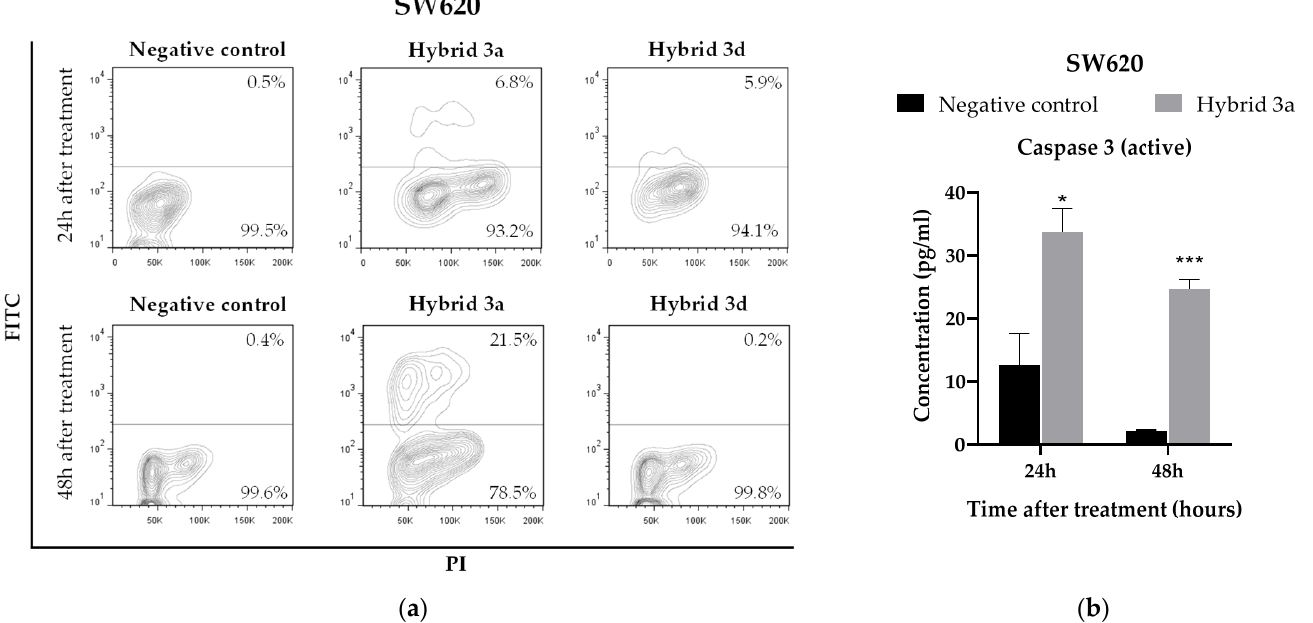
Figure 4. ( a ) Population of apoptotic cells of SW620 cell line treated with hybrids 3a and 3d for 24 and 48 h. ( b ) The concentration of markers associated with the apoptosis process in the SW620 cell line at 24 and 48 h after treatment with hybrid 3a . Data are presented as the mean ± SE of at least three replicates (* p < 0.05; *** p < 0.001 vs. negative control). PI: Propidium Iodide.